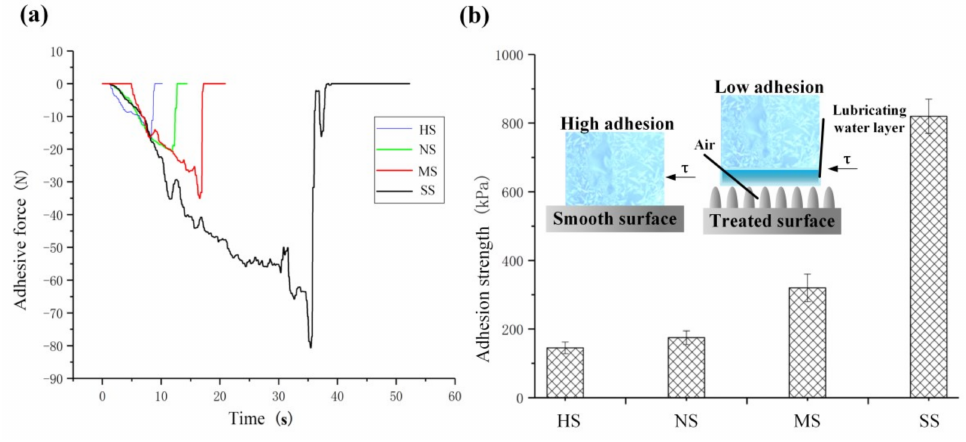
Figure 6. Adhesion test results ( a ) Monitoring curve of dynamometer; ( b ) ice adhesion